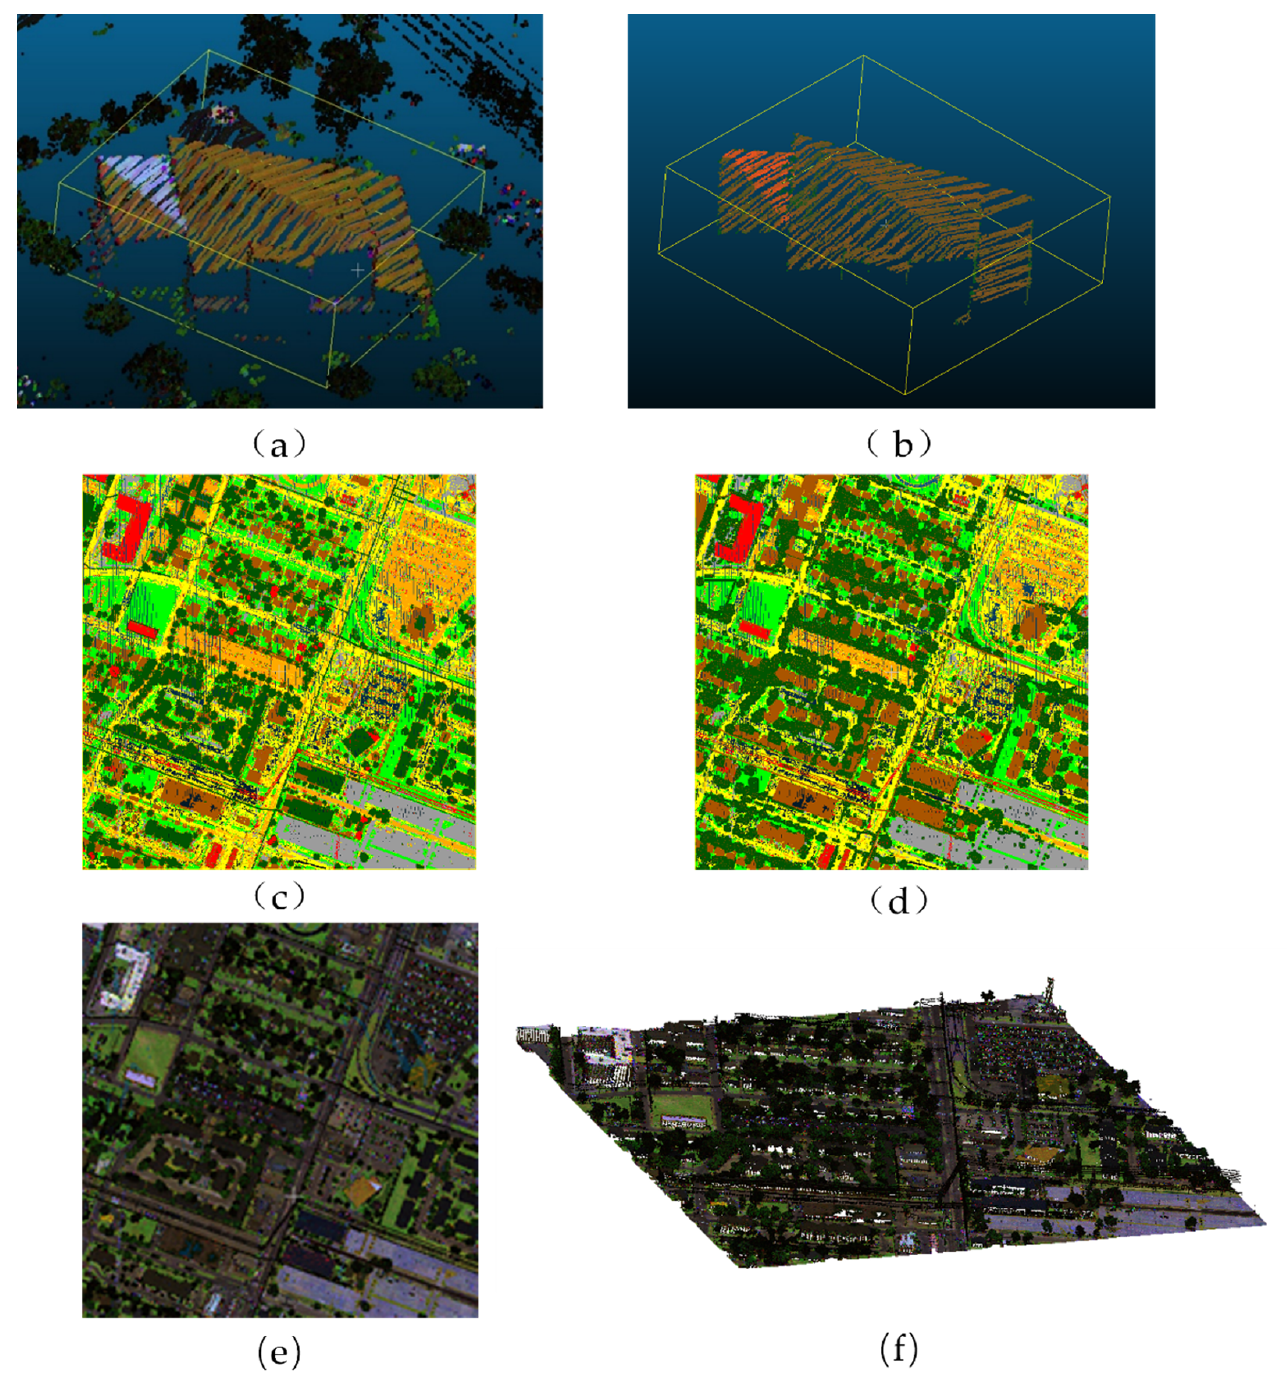
Figure 6. ( a ) Pseudo-color display of conventional processing methods, ( b ) pseudo-color display after segmentation, ( c ) classification results of conventional processing methods, ( d ) classification results after segmentation, ( e ) pseudo-color image by merging the three spectral intensity images, and ( f ) pseudo-color image by merging the three spectral intensity images for 3D representation.